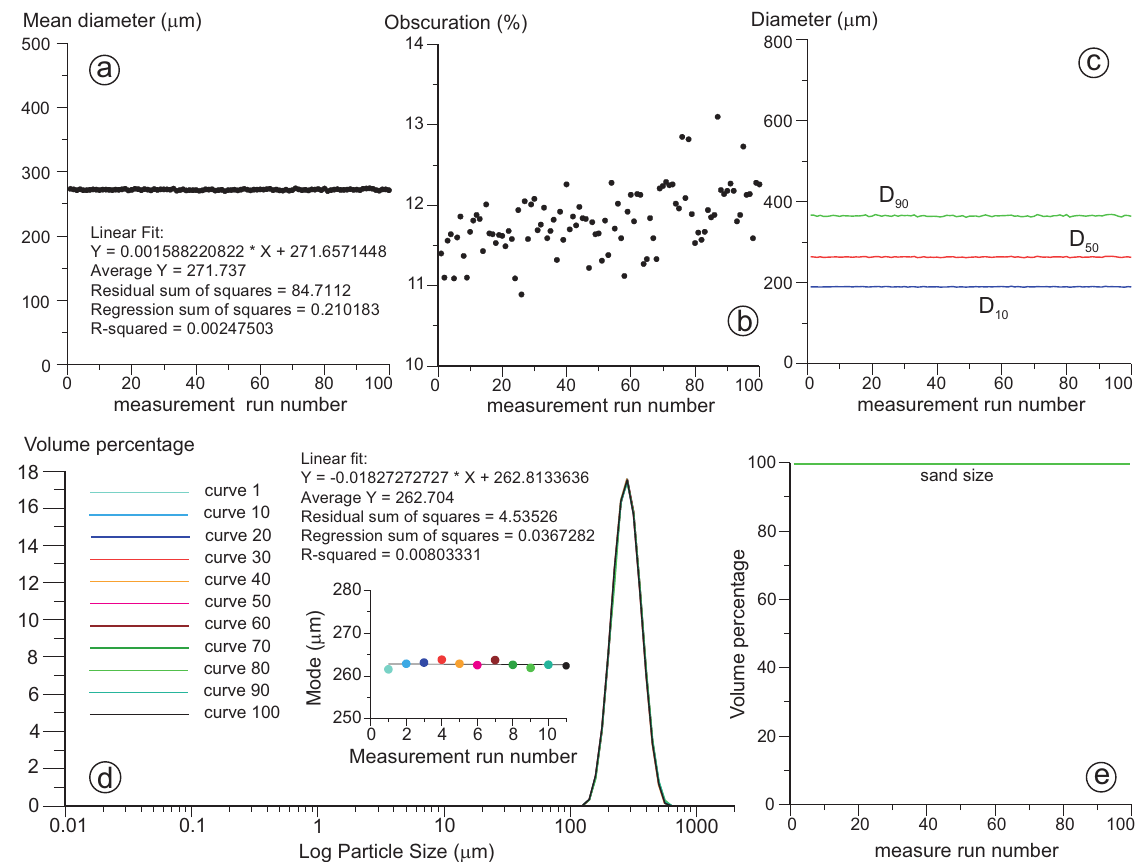
Fig. 8. Results of the measurement precision test MP2500 5 performed on sub-sample aliquot SAND1c by the Hydro 2000 MU dispersion unit. (a) Mean diameter value evolution with increasing the number of measurement runs. Data statistics are provided. (b) Laser obscuration value progression during the same test. (c) Progression of D 10 , D 50 , and D 90 percentiles during the same test. (d) Granulometric curves representative of the particle size evolution. Note their virtually perfect overlap. The corresponding modal values (same colour code) are illustrated in the inset graph, whose statistics are also provided. Note how average modal and mean values are very similar. (e) Distribution of the sand size fractions during the test. It represents 100% of the sample, without any significant amount of clay and